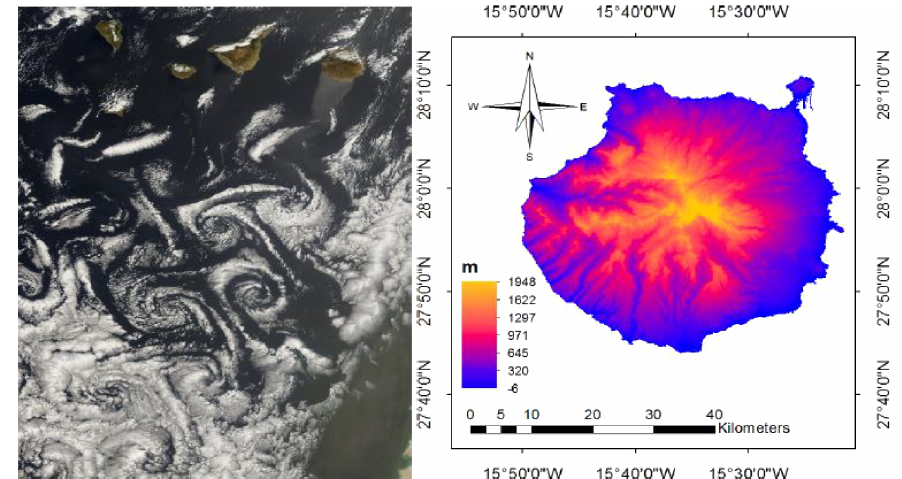
Figure 1. MODIS-TERRA visible satellite imagery of the Canary Islands on 30 April 2007 (left) and SRTM terrain height profile of Gran Canaria (right).